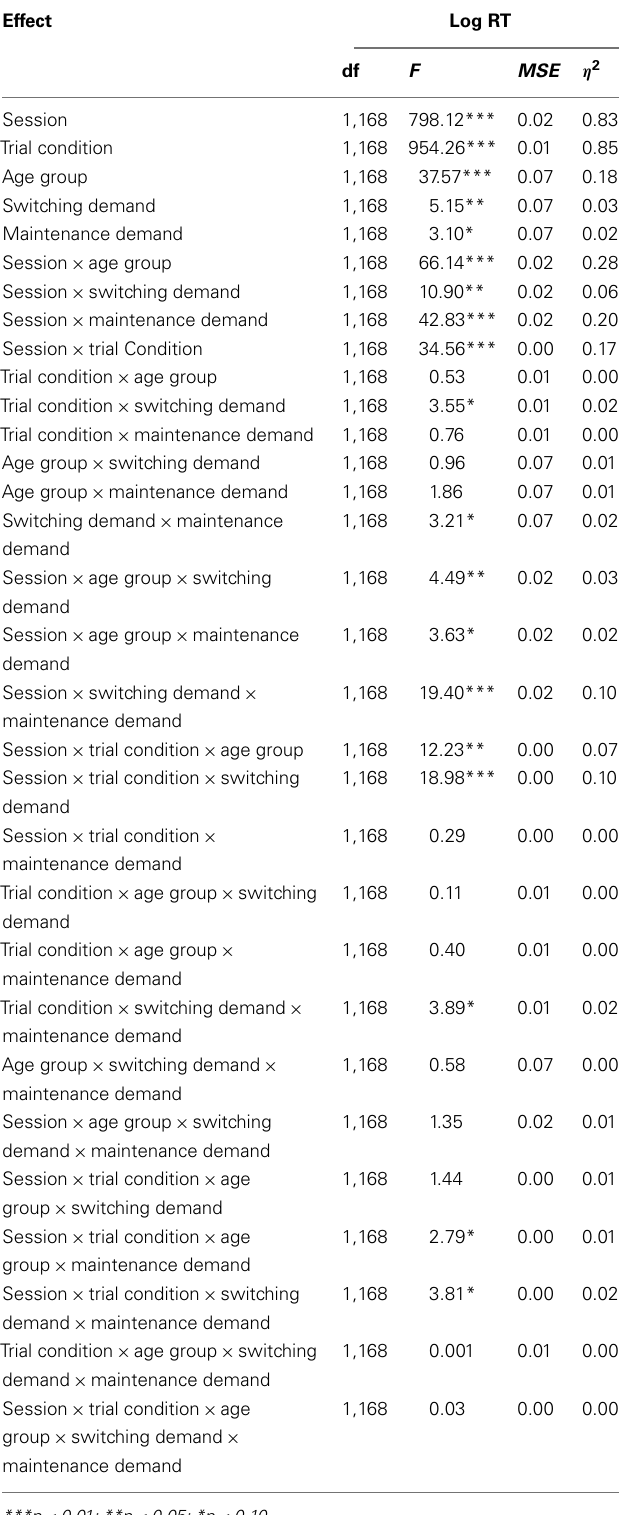
Table 4 |Analysis of variance results for the pretest and posttest data based on log RTs for the Maintenance demand and for the Switching demand groups.